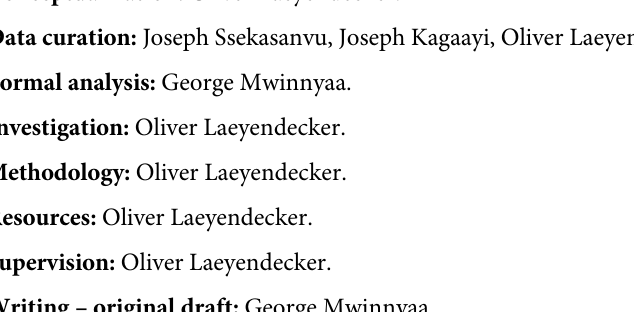
S2 Fig. Supplemental Digital Content 4: HIV EIA results at first visit. S3 Fig. Supplemental Digital Content 5: Future HIV EIA results for individuals with HIV negative results at their first visit. S4 Fig. Supplemental Digital Content 6: Future HIV EIA results for individuals with HIV positive results at their first visit. S5 Fig. Supplemental Digital Content 8: Prevalence of HIV EIA indeterminate results for RCCS participants in Rakai, Uganda (1994–2009). S1 Table. Supplemental Digital Content 2: Factors associated with having two or more HIV serologically indeterminate results among 20000 (87945 person-visits) RCCS partici- pants in Rakai, Uganda (1994–2009). S2 Table. Supplemental Digital Content 3: The prevalence of transitioning from HIV (NN), (PP) or (DD) to HIV negative (N), positive (P) or indeterminate (D) in subsequent follow-up serological tests. S3 Table. Supplemental Digital Content 7: Test kit used for each survey round and the per- centage of samples tested by each test kit. S4 Table. Supplemental Digital Content 9: Factors associated with HIV serologically inde- terminate results among 26375 (62148 person-visits) RCCS participants in Rakai,